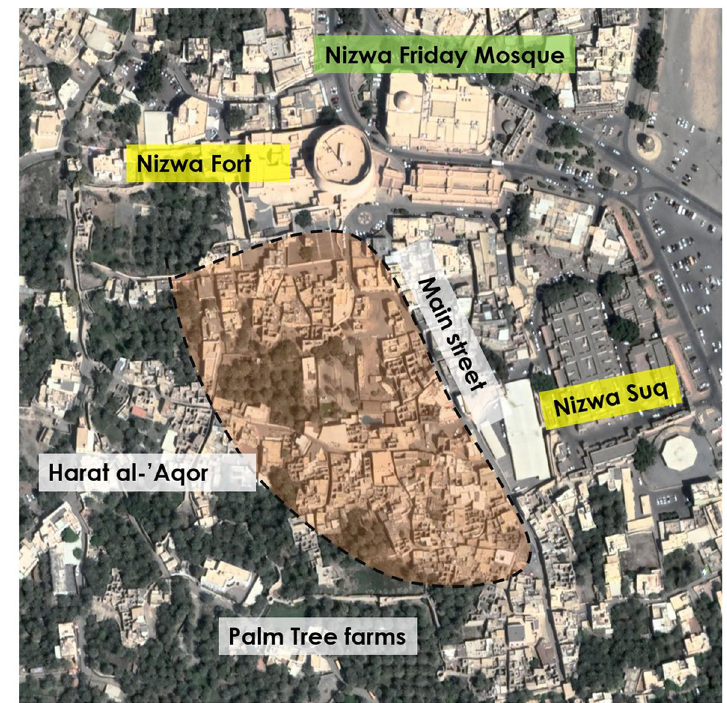
Fig. 9 Harat al-‘Aqr, Wilayat Nizwa, A-Dakhiliyah Region (Source: Google satellite image, enhanced by the